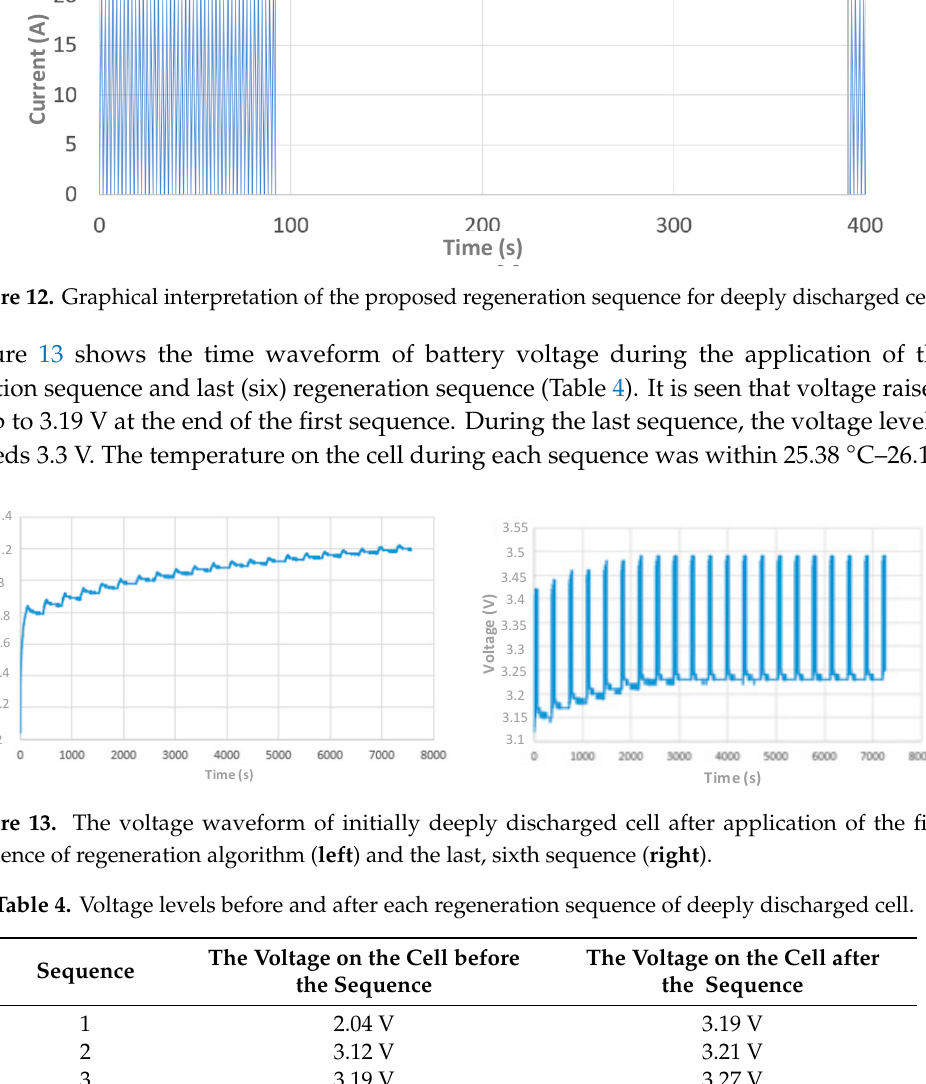
Figure 12. Graphical interpretation of the proposed regeneration sequence for deeply discharged cells.